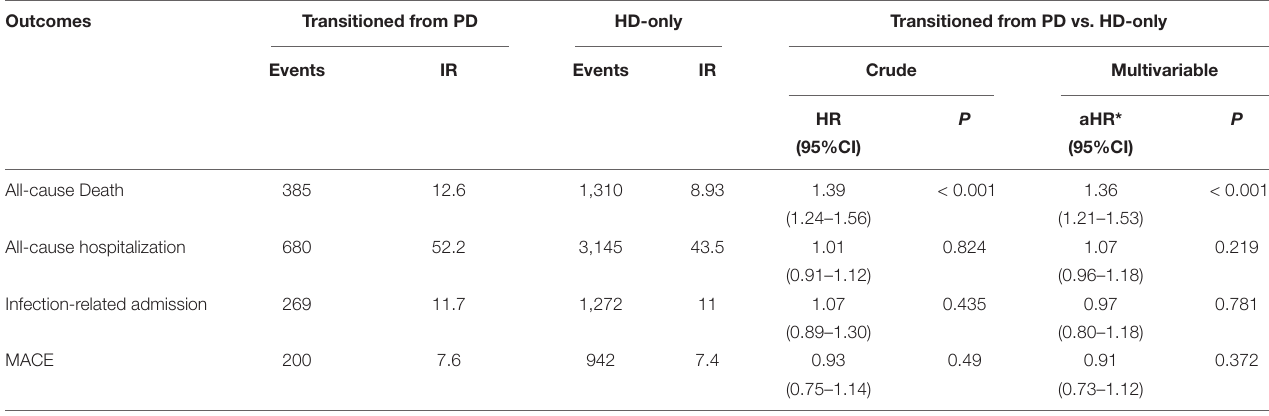
TABLE 2 | Outcomes between hemodialysis patients with/without previous peritoneal dialysis. Outcomes Transitioned from PD HD-only